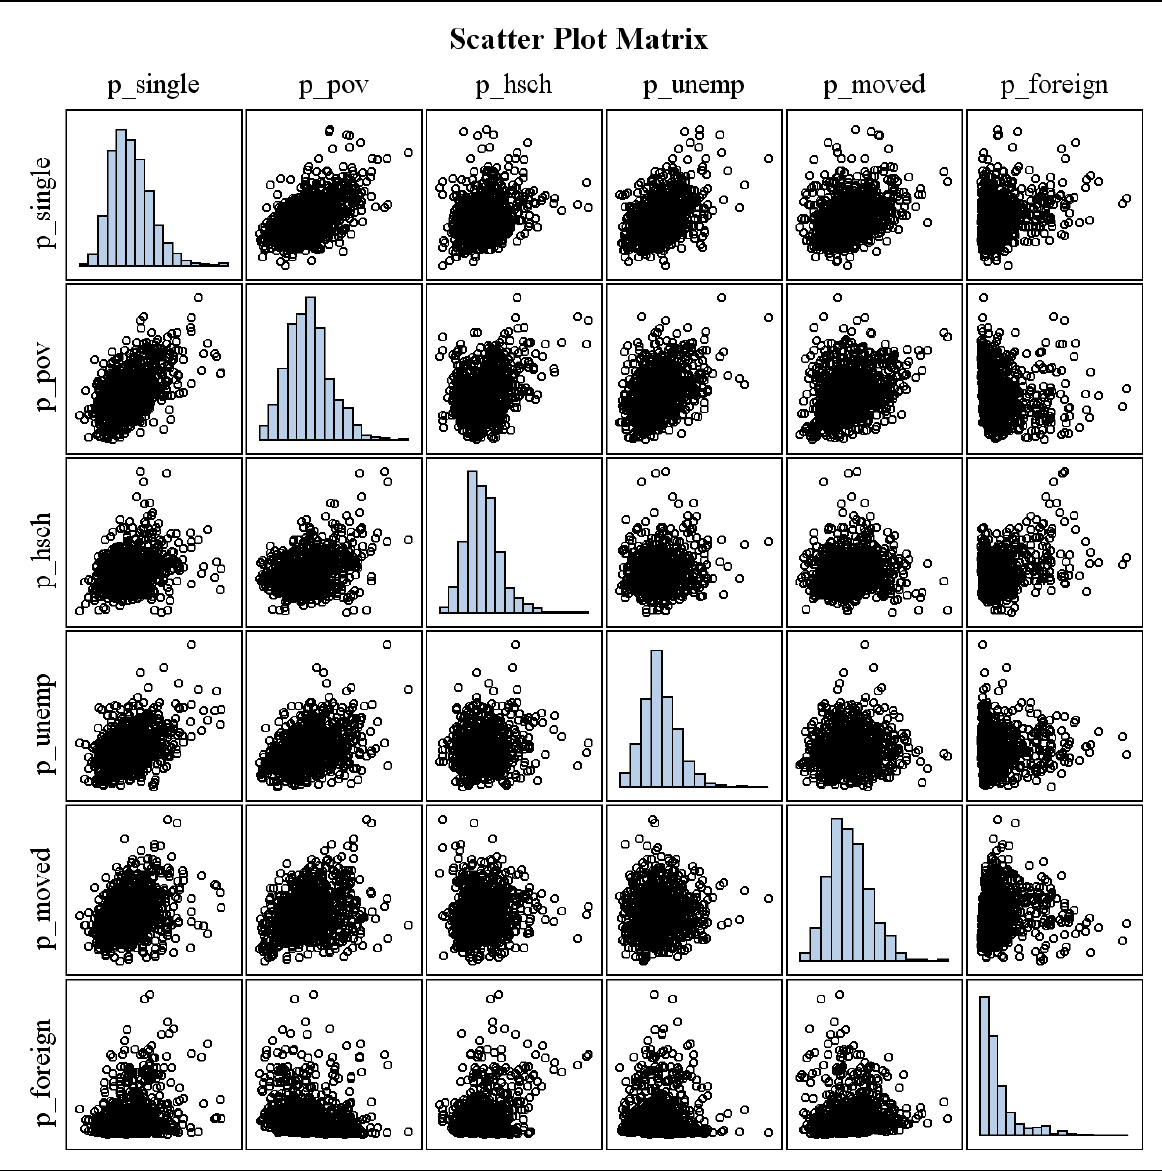
Figure A1. Histograms and scatter plots of the gonorrhea diagnosis rates and both SDH and demographic variables using the original variables (without log